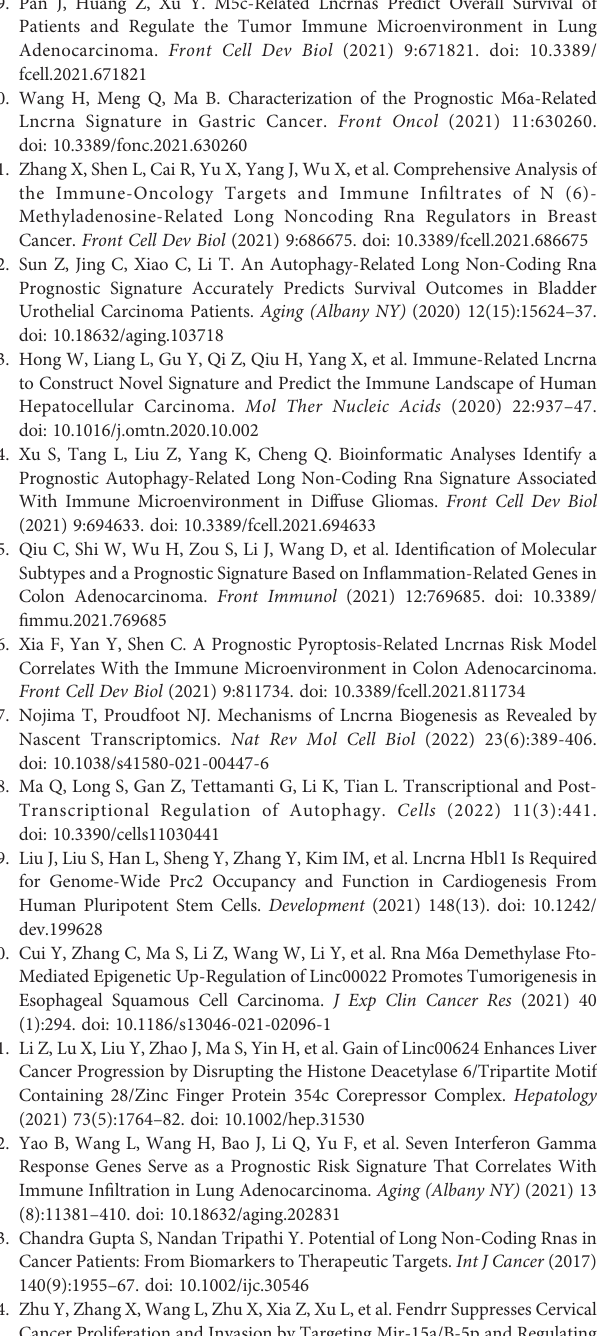
Supplementary Figure 2 | Univariate Cox regression analysis (A) and Multivariate Cox regression analysis (B) of clinical characteristics and risk model scores. Supplementary Figure 3 | Kyoto Encyclopedia of Genes and Genomes (KEGG) pathway enrichment analysis of DEGs between the high- and low-risk